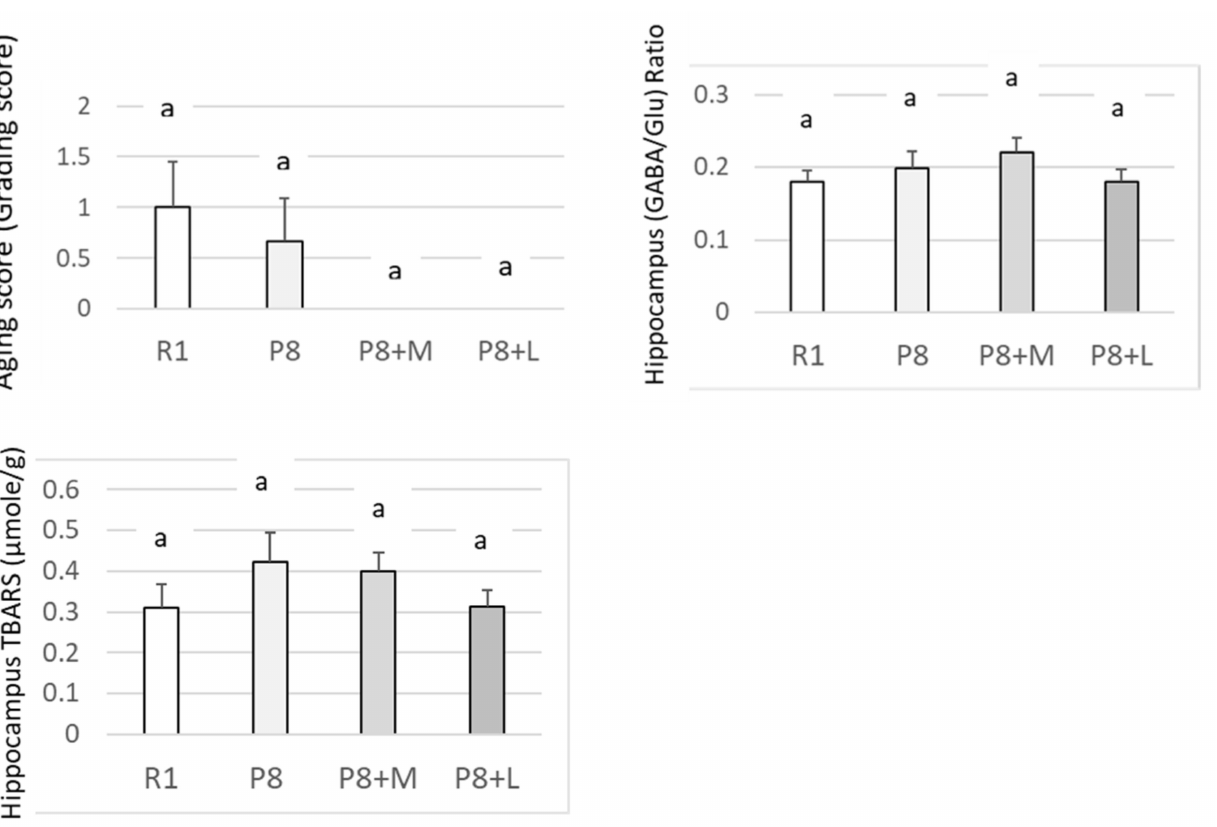
Figure 2. Effects of matcha and decaffeinated matcha on the aging score, hippocampus (GABA/Glu) ratio and hippocampus TBARS levels of SAMP8. R1: SAMR1 group fed with basal diet; P8: SAMP8 group fed with basal diet; P8 + M: SAMP8 group fed with both basal diet and matcha; P8 + L: SAMP8 group fed with both basal diet and decaffeinated matcha. Each value is mean ± SEM. n = 6 for each R1, P8 and P8 + M groups, and n = 5 for P8 + L group. Groups with the same alphameric